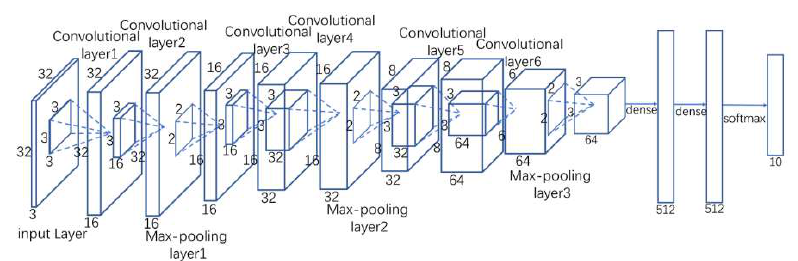
Figure 8. The CNN structure.